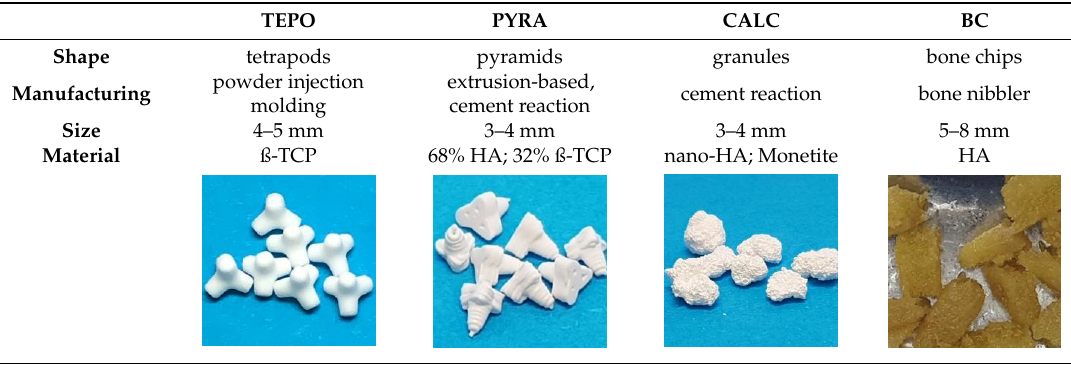
Table 1. Overview of the materials tested.